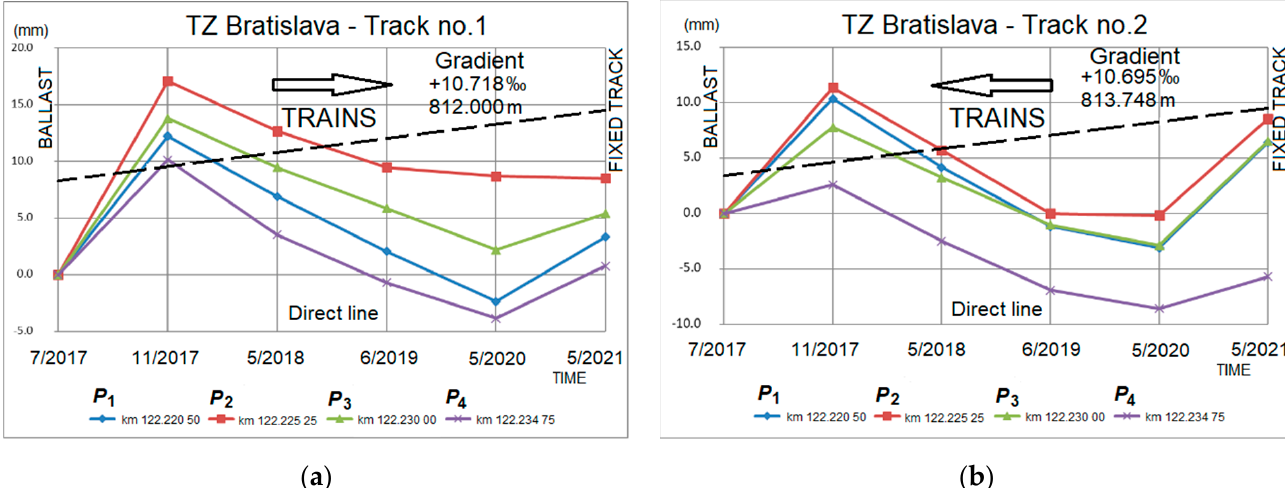
Figure 7. Time dependence of height changes of TZ, towards “Bratislava”: ( a ) Track axis no. 1; ( b ) Track axis no. 2.